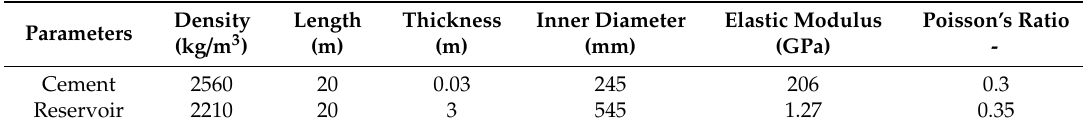
Table 5. Cement and reservoir